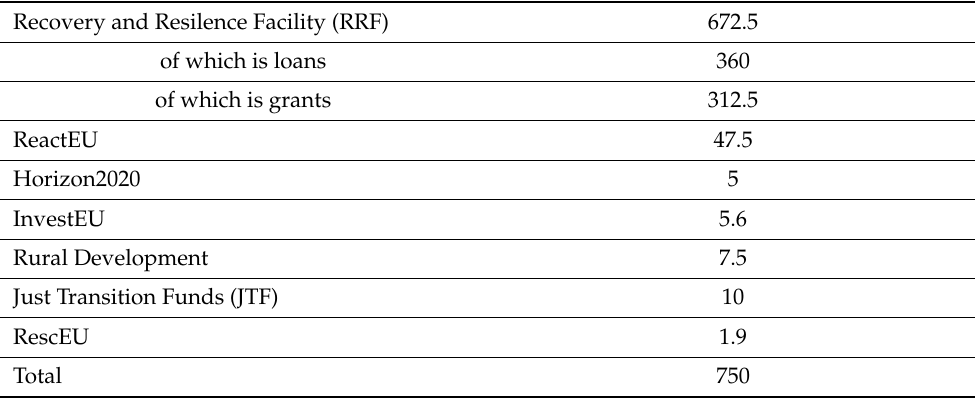
Table 3. Next Generation EU breakdown (in billion EUR, in constant 2018 prices). Recovery and Resilence Facility (RRF)